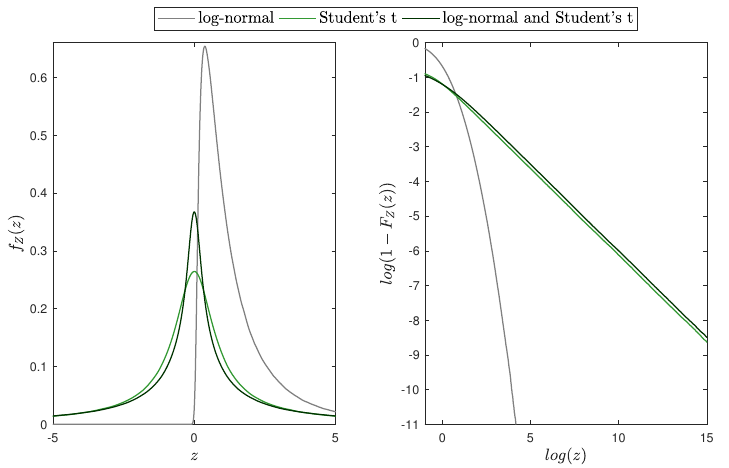
Figure 10. ( Left panel ): the PDF of the random variables X (log-normal), Y (Student’s t ) and Z . ( Right panel ): the distribution tails. The parameters are: µ X = 0 and σ X = 1 and n Y =